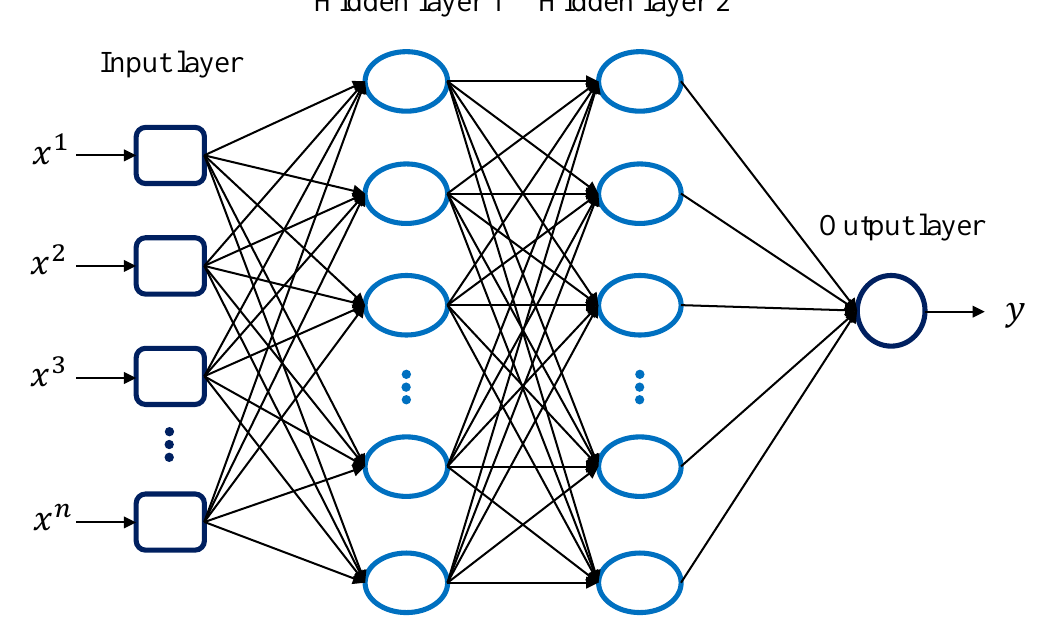
Figure 1. Multilayer perceptron (MLP) architecture with two hidden layers and one prediction